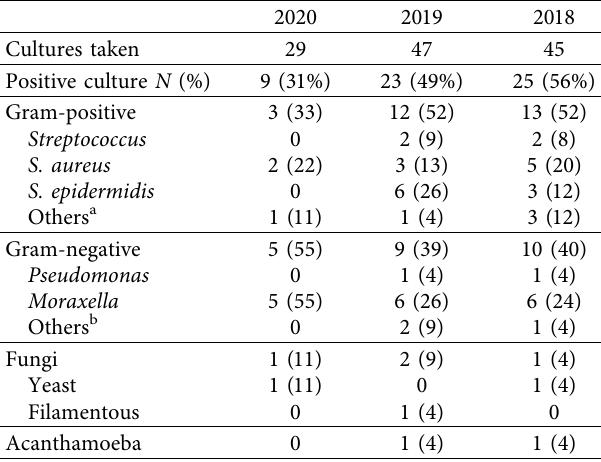
Table 4: Microbiologic profiles of corneal